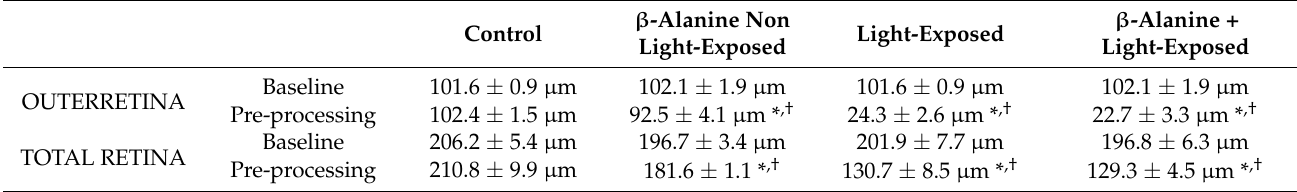
Table 1. SD-OCT retinal thickness measurements in control and experimental animals.